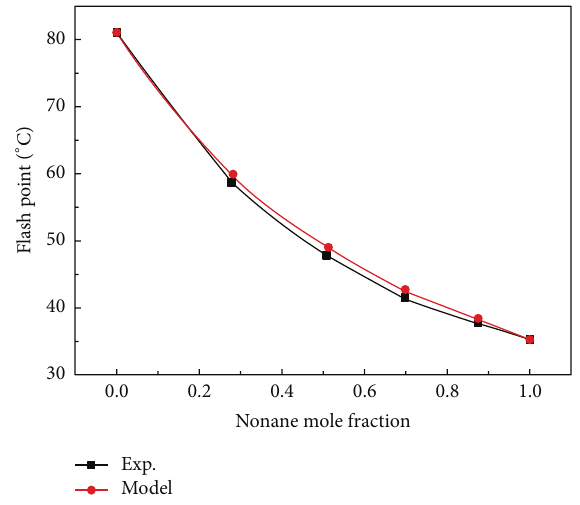
Figure 3: Flash point of nonane + dodecane with different mole